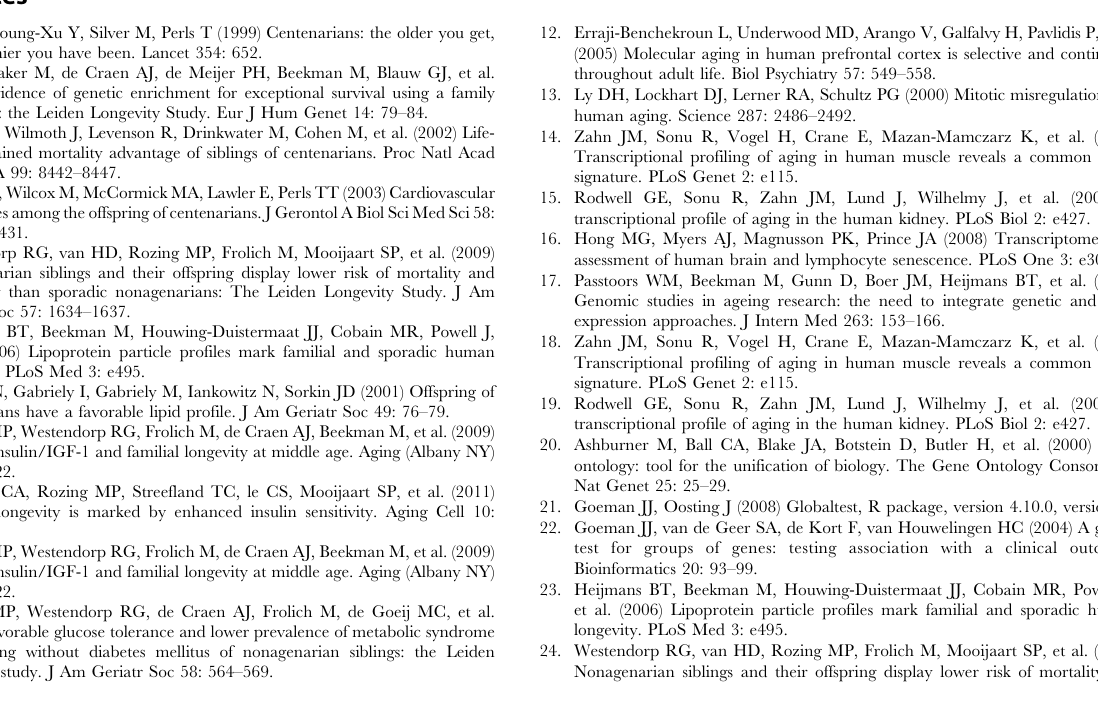
Table S3 List of probes of which the gene expression changes with age significantly differed between off- spring and controls. A total of 360 probes whose expression level changed significantly with age between offspring and controls (regression modeling with FDR multiple testing correction) are shown. ‘‘FC’’ indicates the fold change between offspring and controls per 10 years; a FC above 1 indicates a larger slope of expression as a function of age in offspring, a FC below 1 indicates a larger slope of expression as a function of age in the controls. MULTIPLE indicates a probe annotated to more than 3 chromosomal locations. Table S4 RT-qPCR results of replication samples only. RT-qPCR results of replication samples only are shown. ‘‘FC’’ indicates the fold change between groups; a FC above 1 indicates an increase in expression and a FC below 1 indicates a decrease in expression compared to the controls. ‘‘p’’ indicates the unadjusted p values. Bold indicate p values are below the significant level of 0.05 after Bonferroni correction for multiple